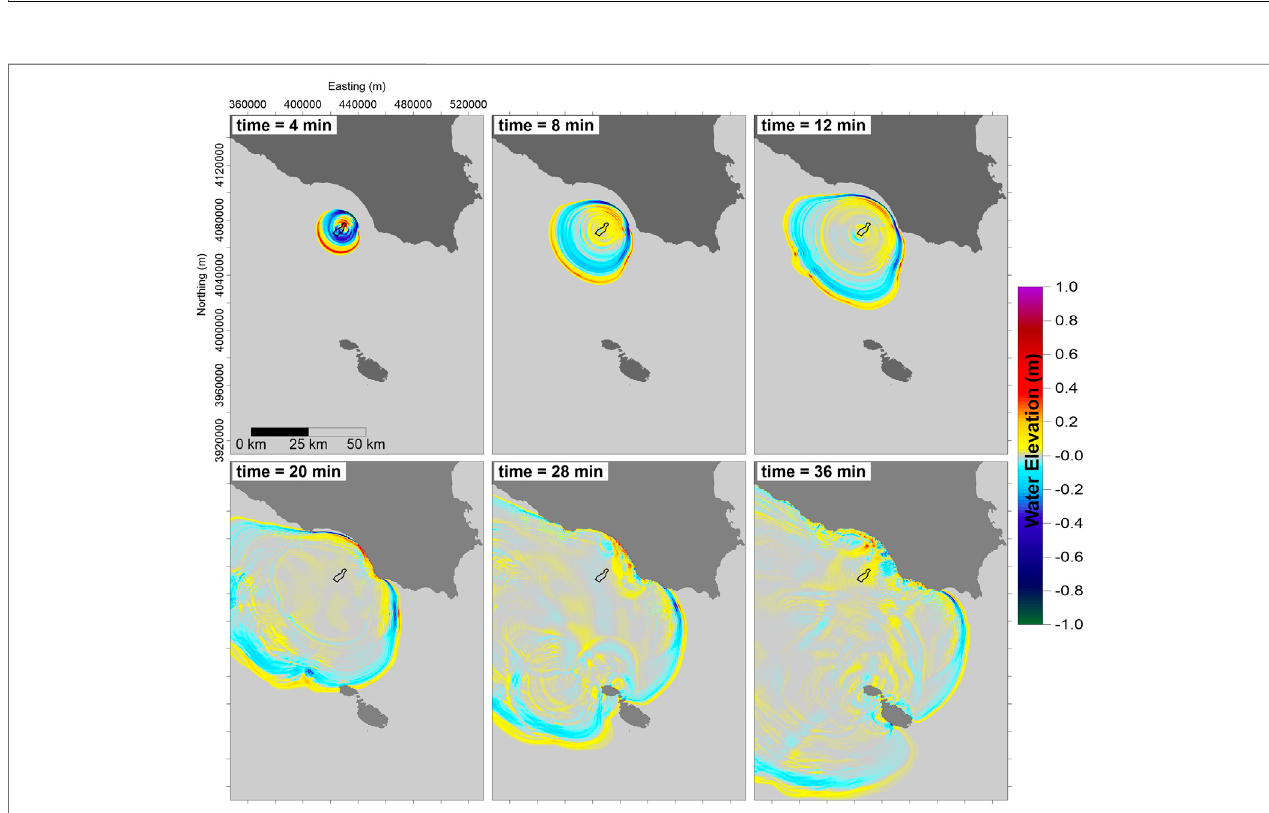
FIGURE 6 | Propagation sketches for the NTS-generated tsunami. The color scale is saturated for values higher than 1 m and lower than − 1 m for graphical reasons. The black contour marks the area swept by the slide.